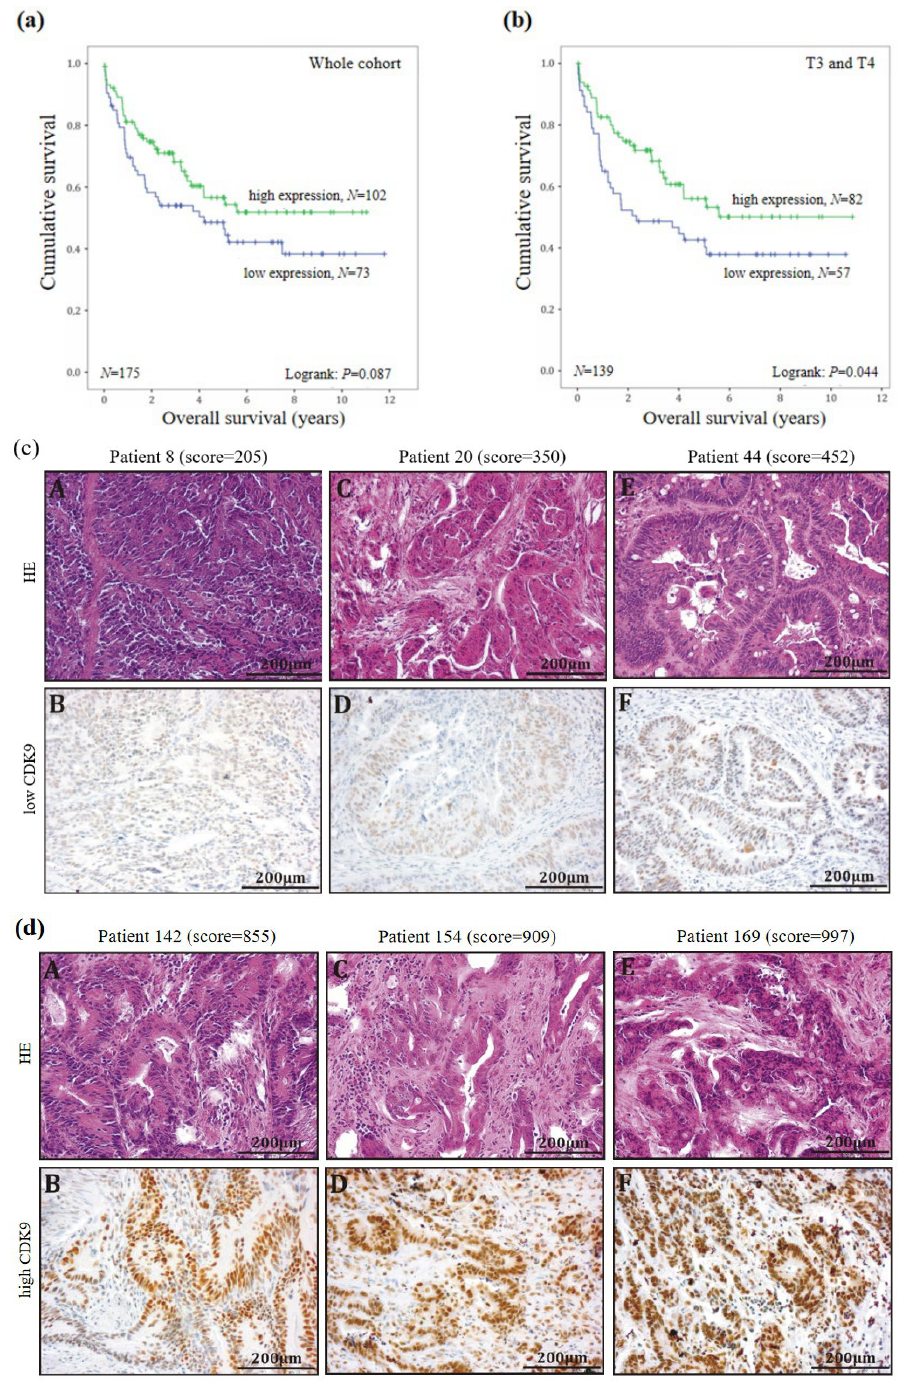
Figure 2. Impact of CDK9 expression on survival of colorectal cancer patients ( a ) and ( b ) Kaplan-Meier survival plot displaying the overall survival of the whole cohort and T3 + T4 according to CDK9 expression in colorectal cancer tissue. Patients with cancer expressing high CDK9 levels show increased survival rates ( p = 0.087 and p = 0.044) compared to those with cancer expressing low CDK9 levels. ( c ) Representative pictures for low CDK9 expressing subgroup (HE and CDK9-im- munohistochemistry), A,B: HE and CDK9 expression in patient 8, C,D: HE and CDK9 expression in patient 20; E,F: HE and CDK9 expression in patient 44. ( d ) Representative pictures for high CDK9